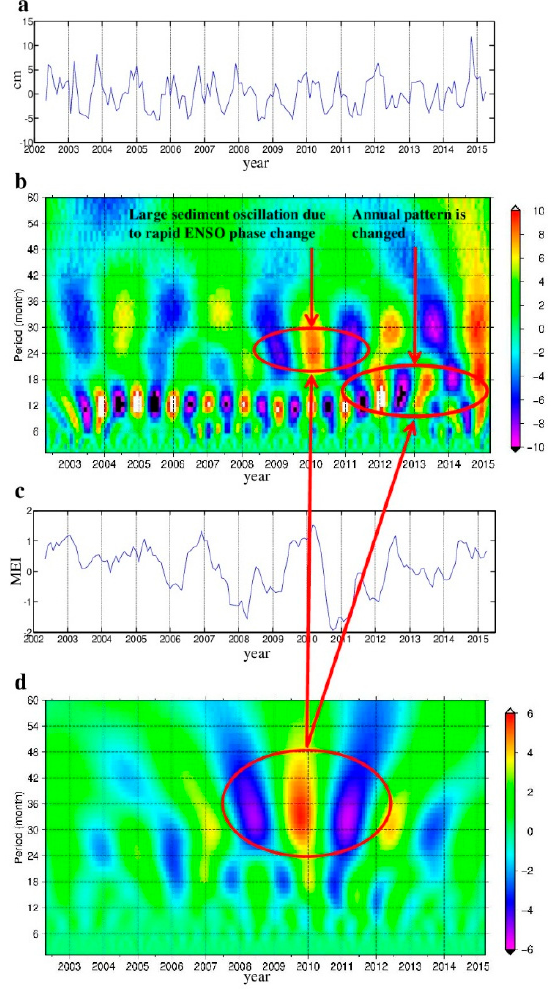
Figure 8. ( a ) Time series of detrended GRACE-derived EWHs and ( b ) their wavelet spectrum; ( c ) Time series of the Multivariate ENSO Index (MEI) obtained from NOAA [36] and ( d ) its wavelet spectrum.